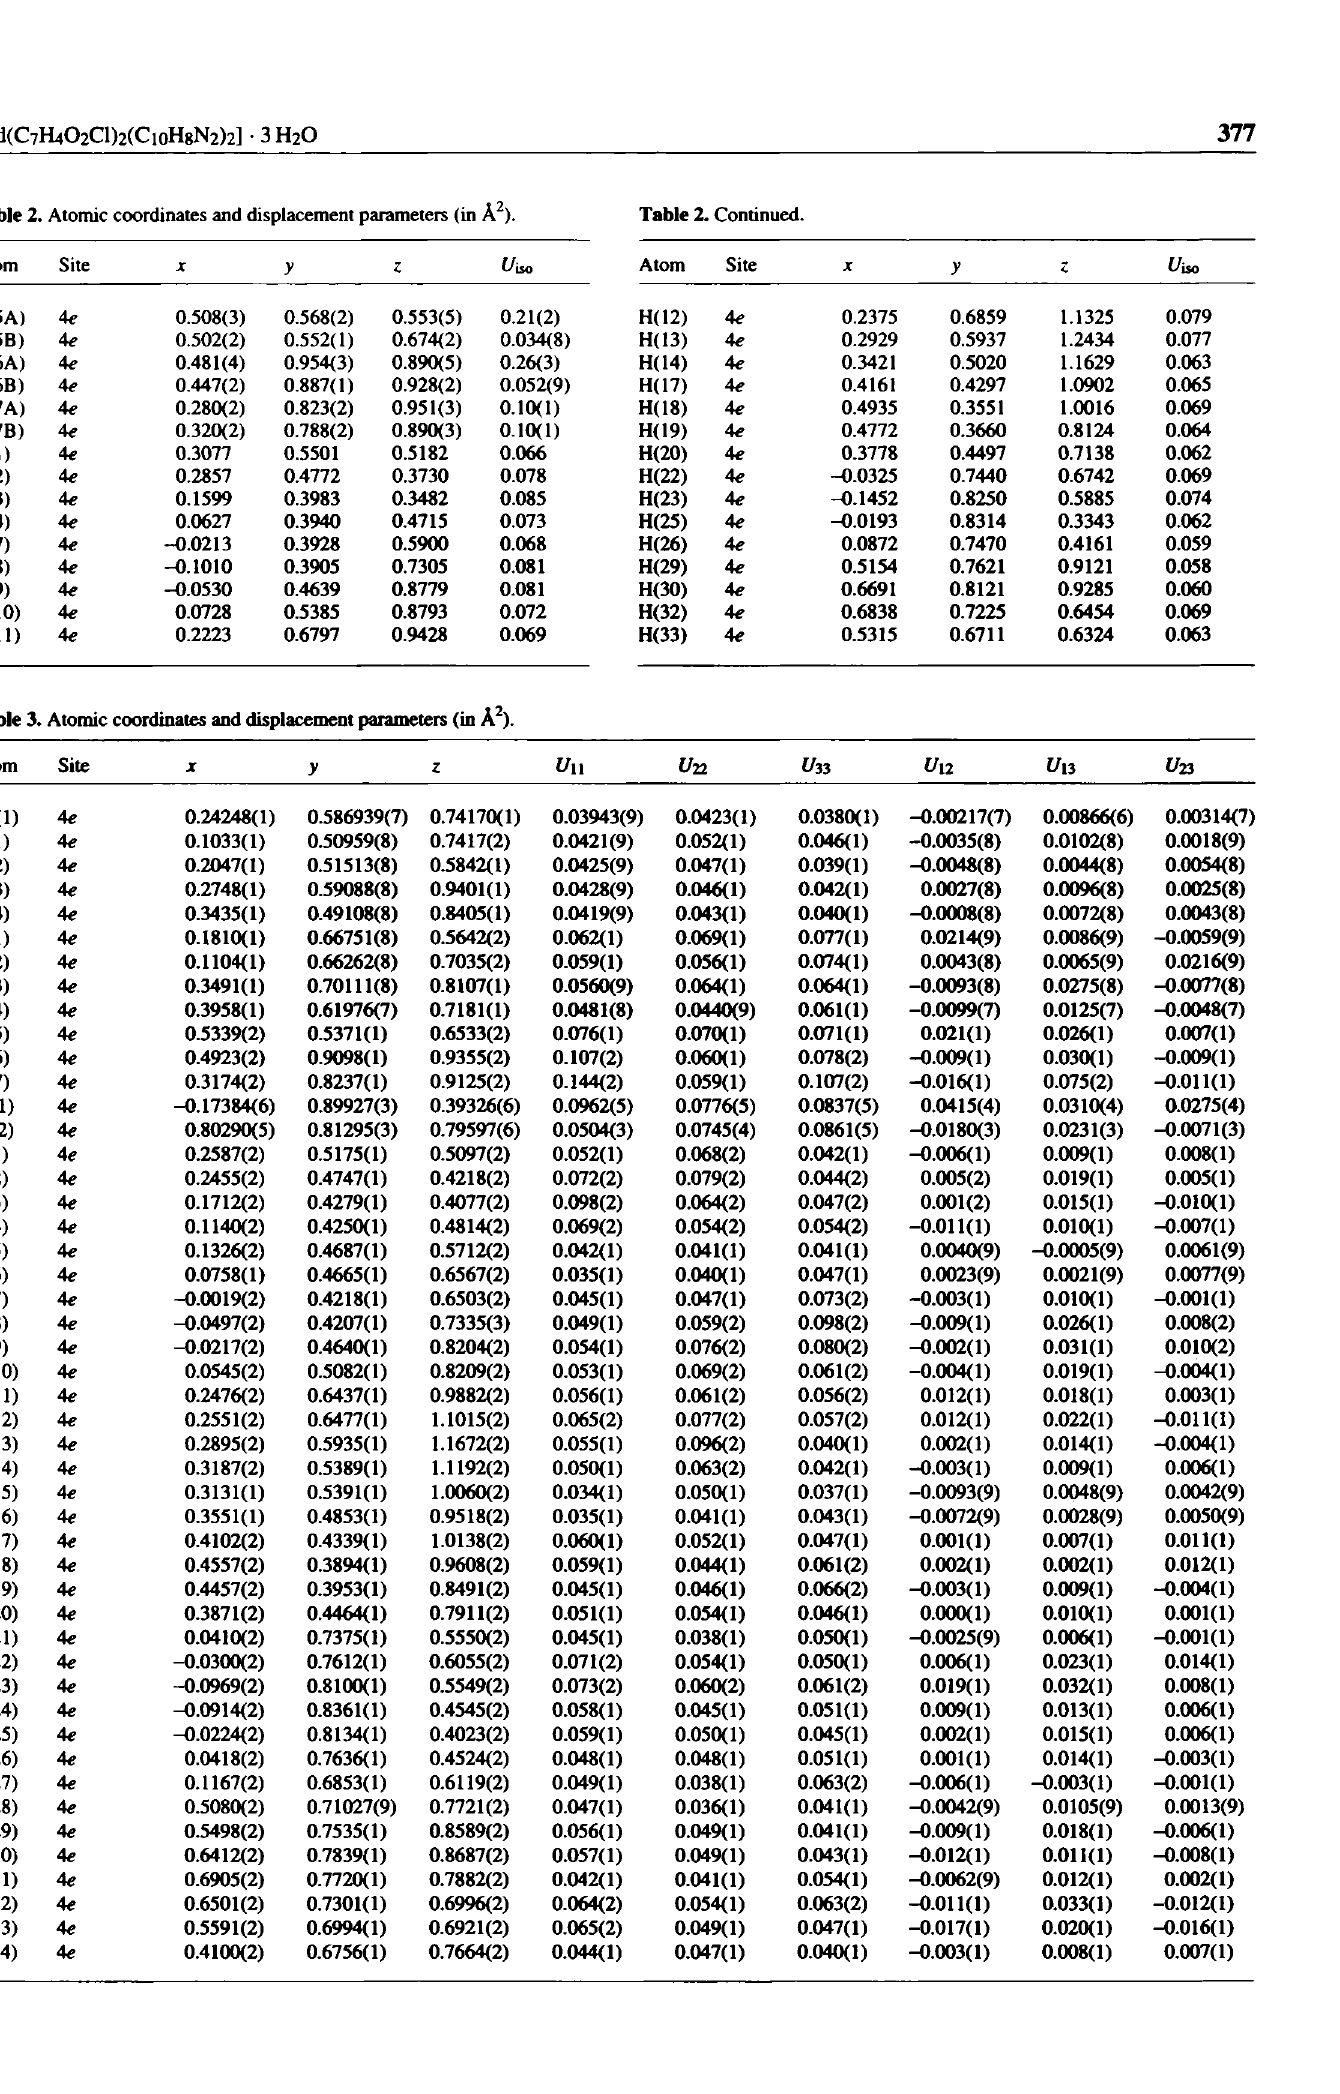
Table 3. Atomic coordinates and displacement parameters (in A 2